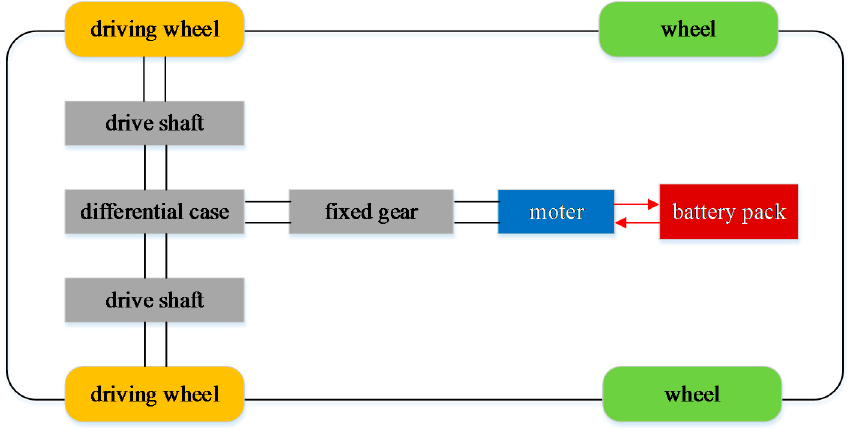
Figure 3. The EV powertrain topology of a central drive powertrain. Table 1. The specifications of the baseline electric motor.